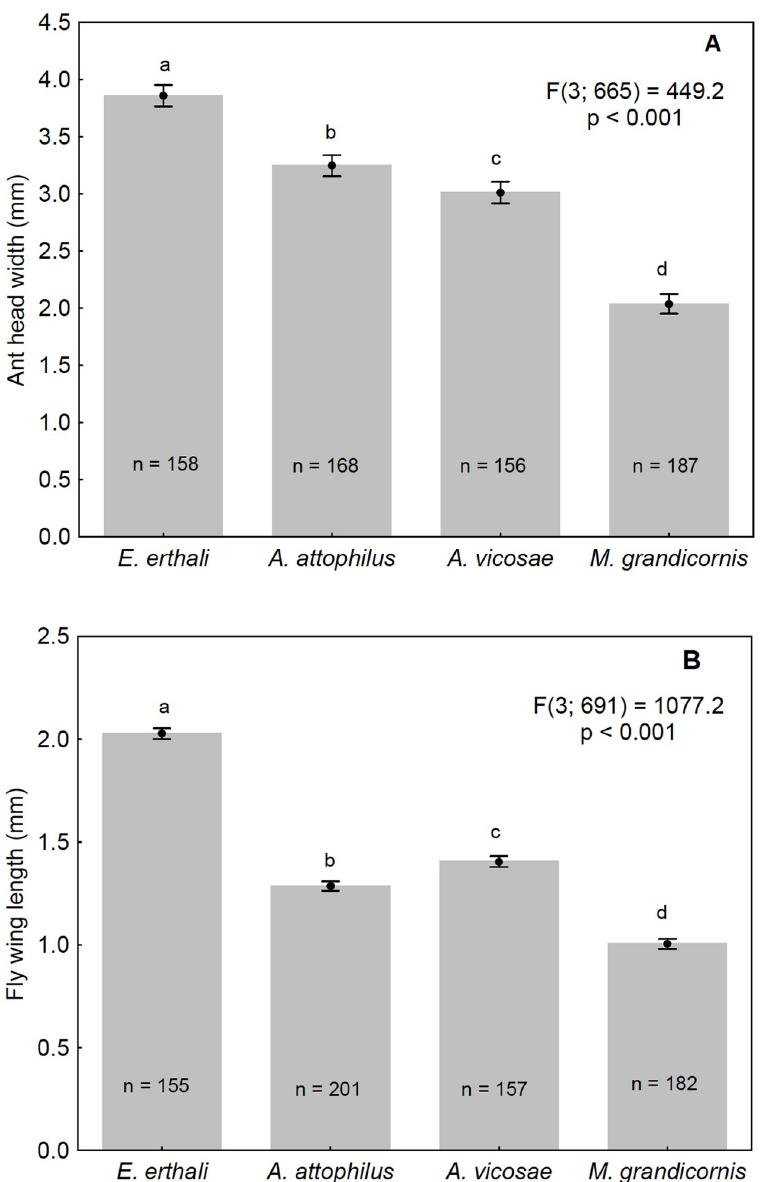
Fig 3. (A) Relationship between Atta laevigata worker size and the phorid species parasitizing these ants; (B) Size (wing length) of the four species of phorids. Note: Vertical bars indicate 95% confidence intervals and different letters indicate significant differences in ant cephalic capsule width and phorid wing length. A one-way ANOVA and the Tukey test at the 5% level were used for comparisons. Data was transformed using box-cox: λ = -0.30 (A); λ = -0.55